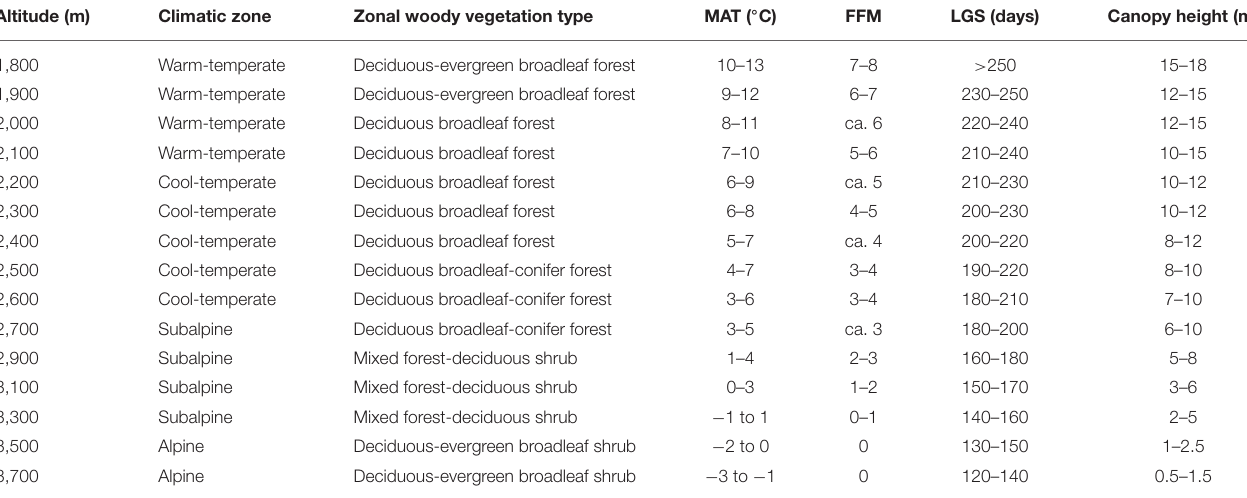
TABLE 2 | The meteorological parameters at each sampling altitudinal transect are the approximate range of climate change for many years in the study area. Altitude